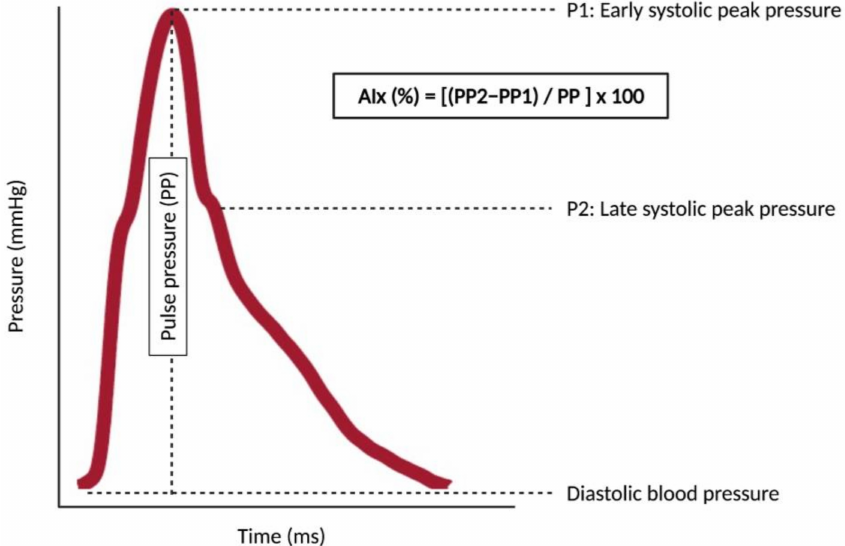
Figure 2. The concept of augmentation index and augmentation pressure. The figure shows a pulse waveform with two peaks: P1 is an early systolic peak pressure (derived from the forward component of the pulse wave) whereas P2 is a late systolic peak pressure (derived from the backward component of the pulse wave). Pulse pressure (PP) is the difference between the central systolic blood pressure and the central diastolic blood pressure. PP2 is the pulse pressure of the P2, and PP1 is the pulse pressure of the P1. The augmentation pressure is the difference between the PP2 and the PP1. The augmentation index (AIx) is the augmentation pressure divided by the PP and multiplied by 100 to give as a percentage. When the aorta stiffens, reflected waves arrive earlier in the systole, the P2 value is higher as well as the augmentation pressure and the AIx. As the AIx is highly dependent on heart rate, it should be reported as its value for a heart rate of 75 bpm (AIx75). The assessment of AIx75 requires only one recording site (usually radial or carotid) for recording the pulse waveform with a device provided with a transfer function for calculating the AIx as well as other pulse waveform-derived measures (e.g., subendocardial viability ratio), which makes its assessment easier than the evaluation of pulse wave velocity (see Section